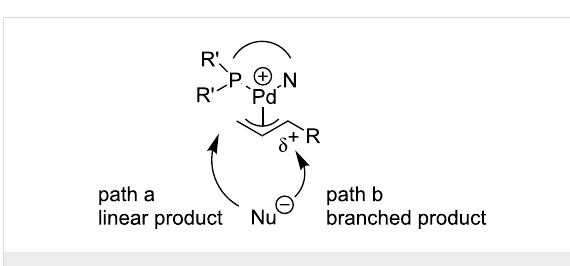
Figure 2: Preliminary explanation of the